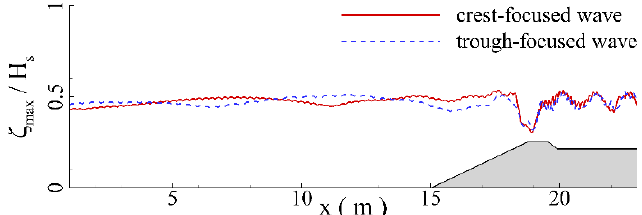
Figure 10. Space distribution of the local maximum water elevation.